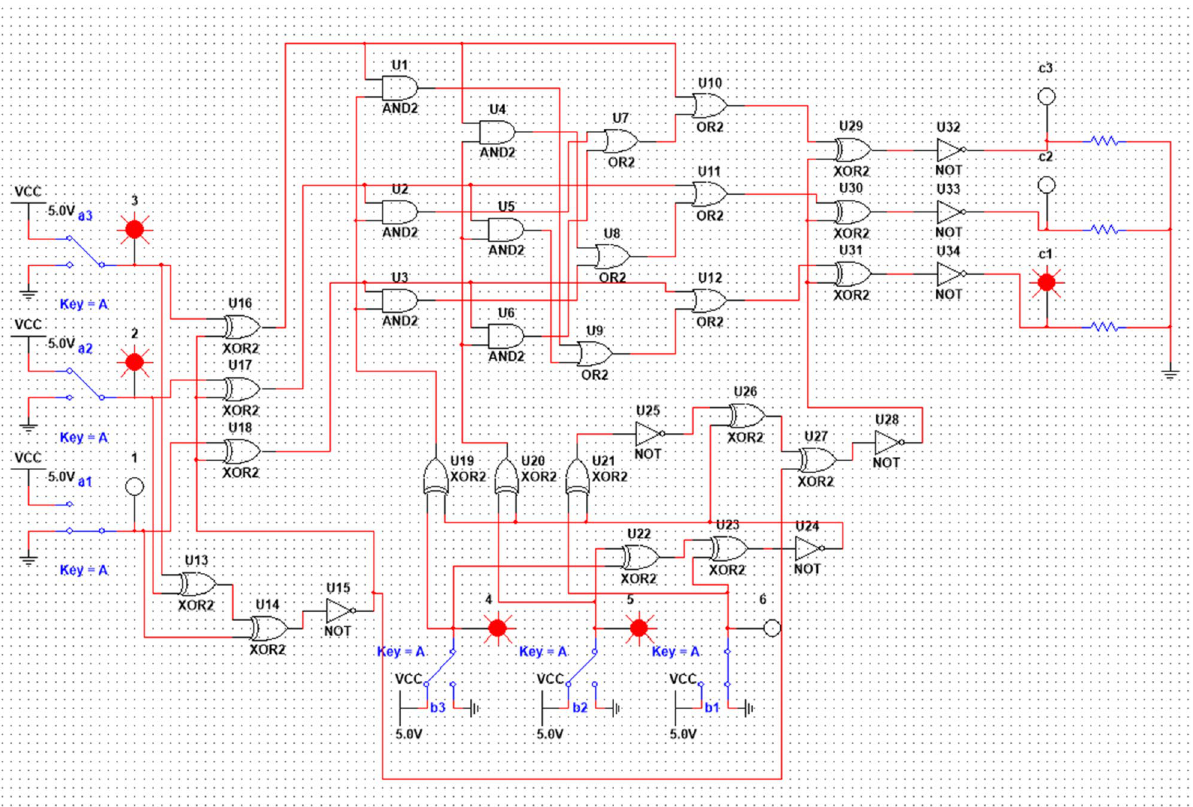
Figure 5. Multiplier circuit modulo seven, assembled in the NI Multisim program. (Image was generated in NI Multisim 14.1 https:// www. ni. com/ ru- ru/ suppo rt/ downl oads/ softw are- produ cts/ downl oad. multi sim. html#